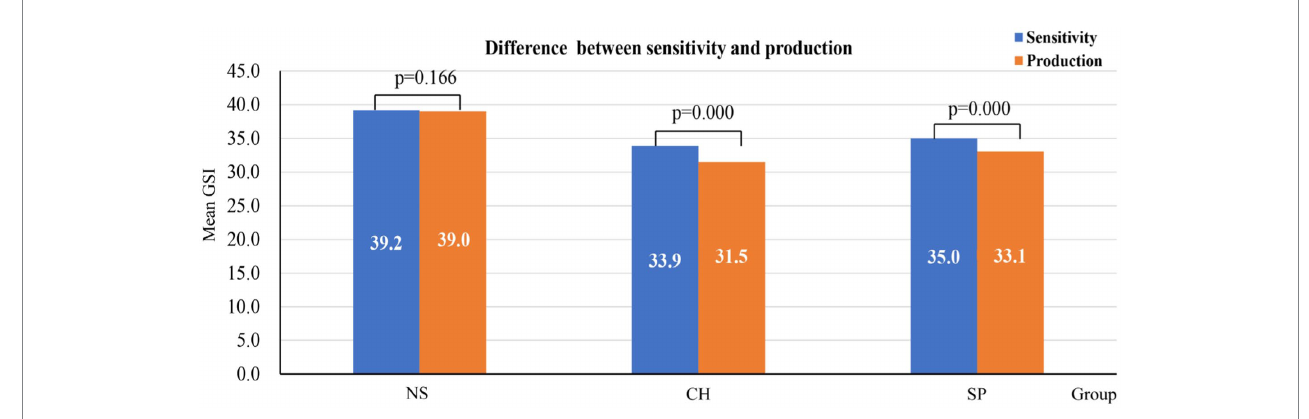
FIGURE 2 Paired t -test of difference between sensitivity and production. NS, native speaker; CH, Chinese speaker; SP, Spanish